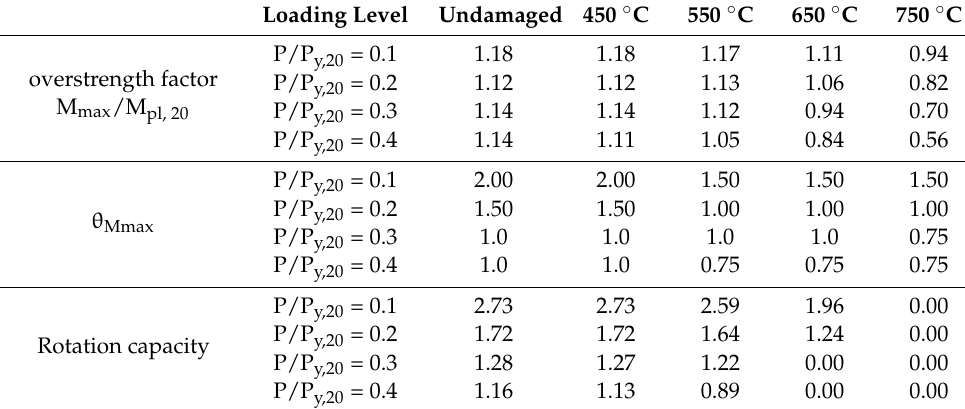
Table 4. Summary of the results for the HEA340 columns.